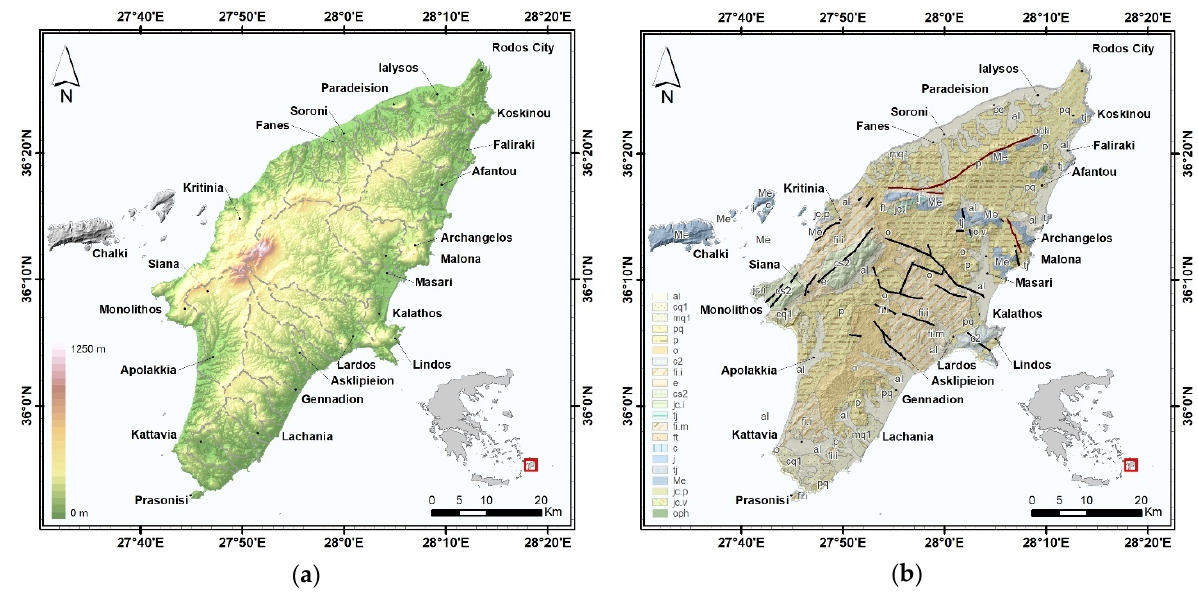
Figure 1. ( a ) Digital elevation model of Rhodes Island (Greece), indicating the most popular tourist coastal destinations. ( b ) Simplified geological map of Rhodes. Key: al, Holocene alluvial sediments; cq1, Pleistocene terrestrial and lacustrine sediments; mq1, Pleistocene marine sediments; pq, Pliocene–Pleistocene lacustrine and fluvial sediments; p, Pliocene lacustrine sediments; o, Oligocene molasse formations; c2, Cenomanian–Maastricht carbonate rocks; fl.i, flysch; e, Paleocene—upper Eocene carbonate rocks; cs2, upper Senonian carbonate rocks; jc.i, Jurassic—lower Senonian carbonate rocks; tj, upper Triassic—Jurassic carbonate rocks; fl.m, lower Oligocene flysch sequence; ft, flysch sequence; c, Cretaceous carbonate rocks; j, Jurassic carbonate rocks; Me, Mesozoic–Eocene carbonate rocks; jc.p, Jurassic and Cretaceous flysch sequence; jc.v, Jurassic—lower Cretaceous flysch sequence; oph, ophiolites; red solid lines, subsurface faults; black solid lines, surface faulting.